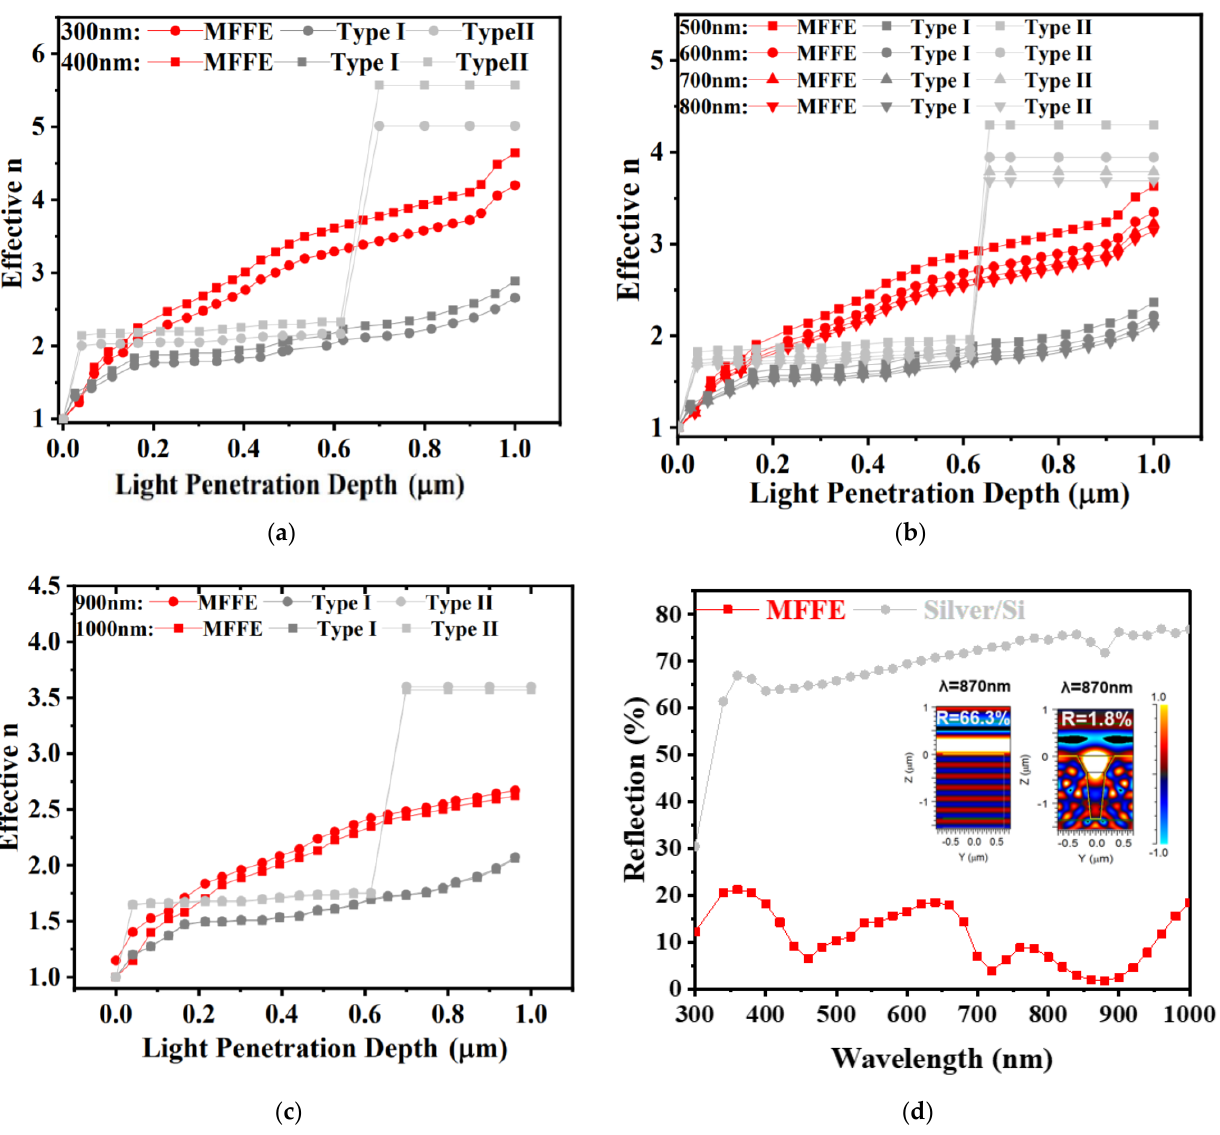
Figure 3. The calculated correlation between effective refractive index (n) and light penetration depth in ( a ) ultra-violet light; ( b ) visible light; and ( c ) near-infrared light. These results illustrate that MFFE provides the linear gradient refractive index compared with the others in this work; ( d ) the simulated optical reflection by three-dimensional finite-differential time-domain (FDTD) software.